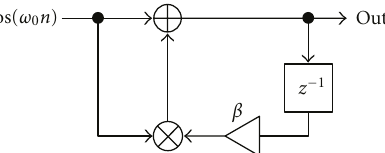
Figure 5: Flowchart of the basic FBAM equation, where z − 1 denotes the delay of a unit sample period.